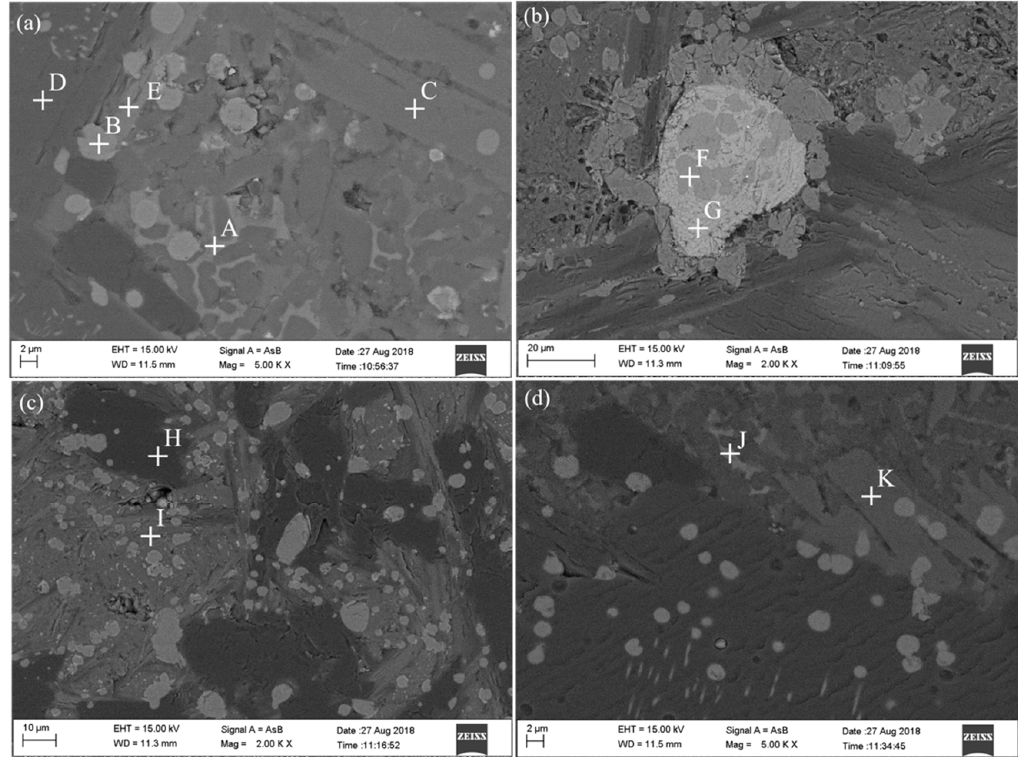
Figure 6. Microstructures of slag produced from ilmenites with different reduction degrees, shown at higher magnification. ( a ) 0%, ( b ) 11%, ( c ) 43%, and ( d ) 75%.